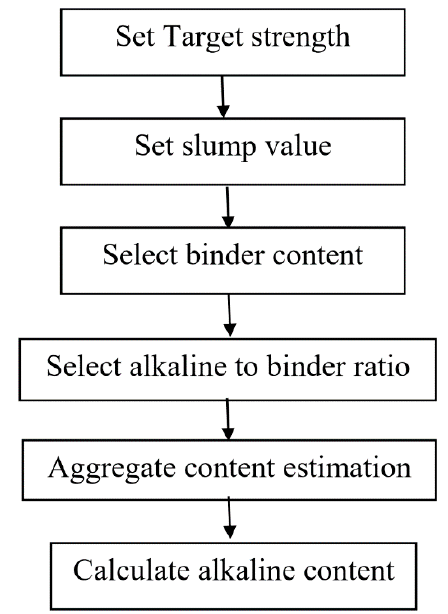
Figure 3. Flow chart by hit and trial method modified from [77], Springer, 2012.